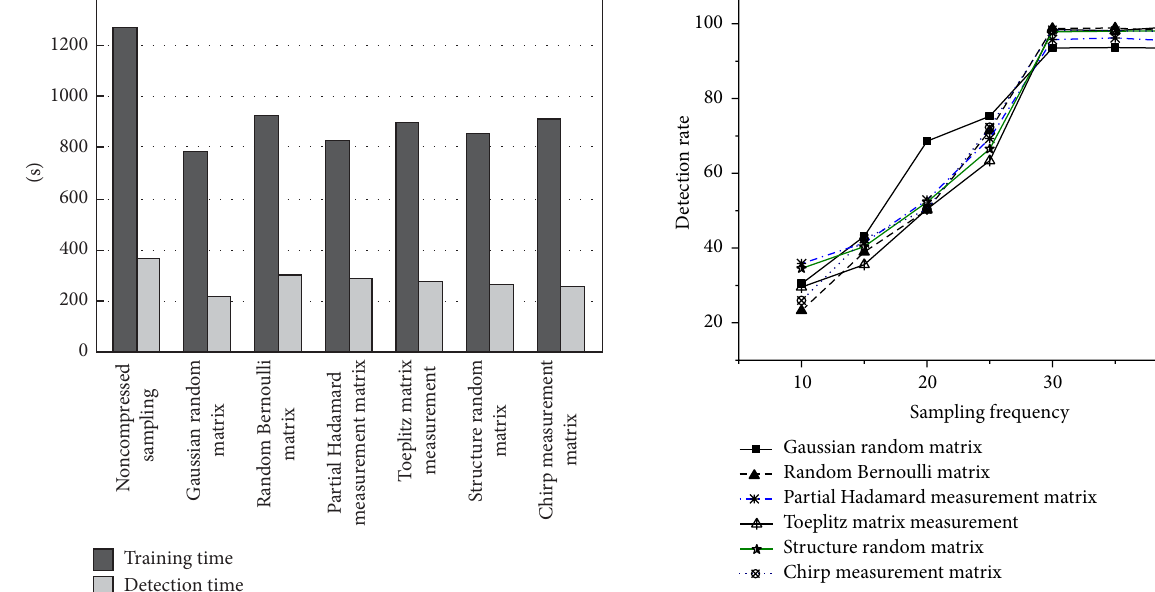
Figure 3: Detection rate of the 𝐾 -nearest neighbor algorithm as a classifier for DoS